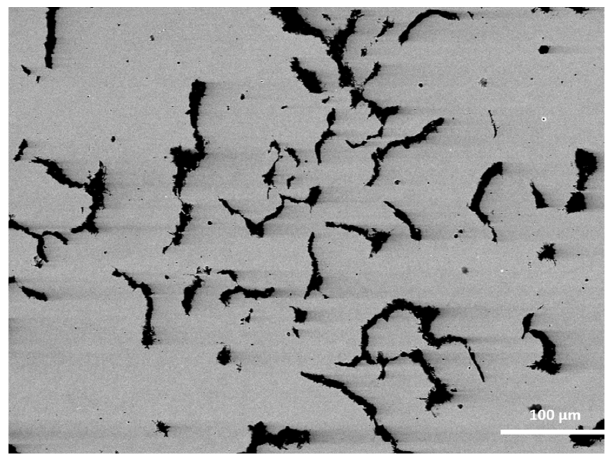
Figure 2. Microstructure of the compacted graphite cast iron. Table 2. Chemical composition of the CGI substrate.